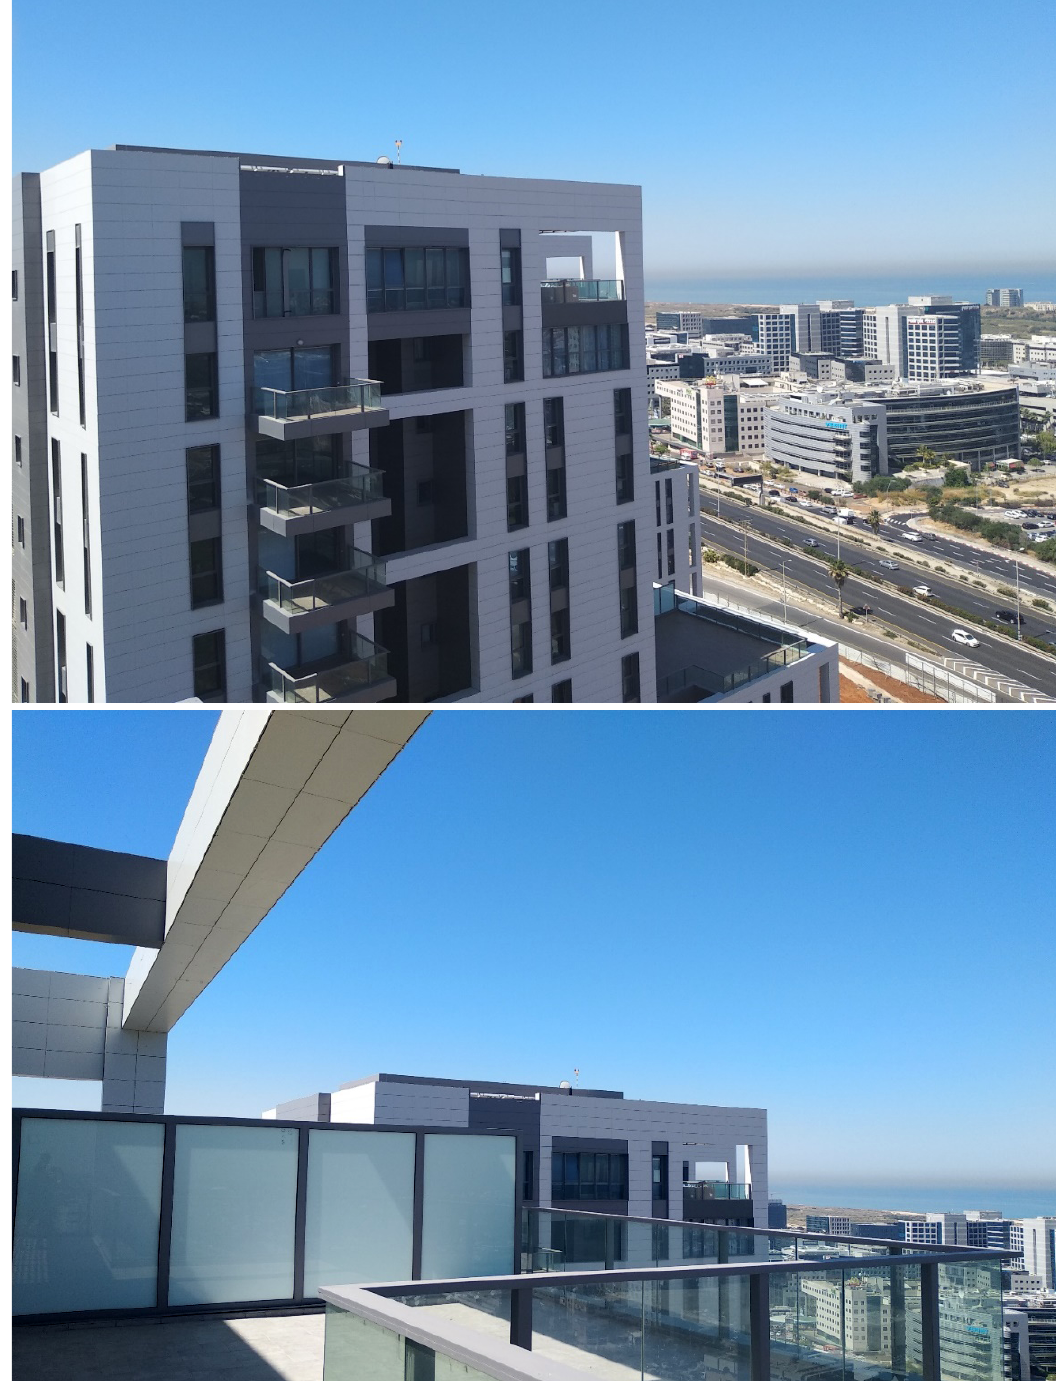
Figure 6. The ‘dress’ from the penthouse floor. Source: Authors (2019). Designed by Danish architects from BIG in 2009, 8 House comprises 505 apartments with an overall hous- ing area of 538,195 square feet, siting on 129,167 square feet of commercial space (Stephens, 2009). Rich in apart- ment types and combining mixed-use spaces for of- fices and communal services, the LUD is unified via an overarching structural layout in the form of the num- ber 8, producing a holistic form and organizing element (Figure 8). While embodying a complex mix of